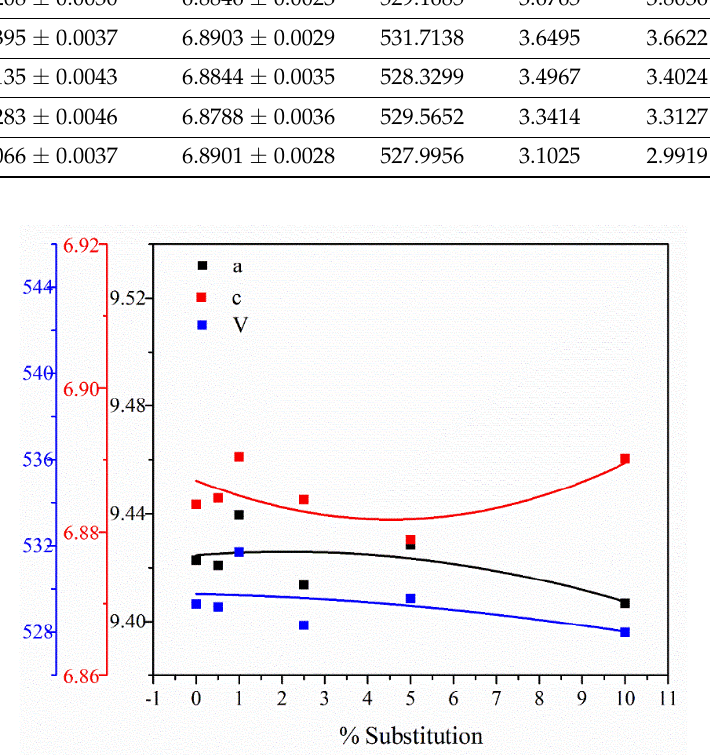
Figure 3. Unit cell parameters ( a , c , V ) vs . substitution degree for Ca 10 − x Tb x (PO 4 ) 6 (OH) 2.